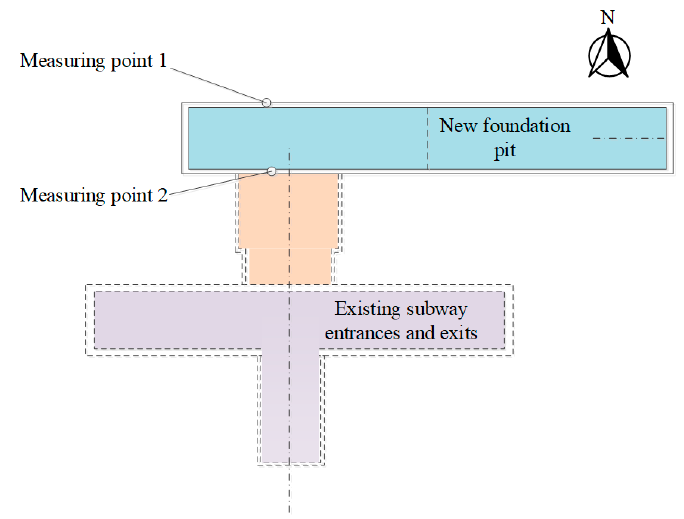
Figure 1. Plane position of new foundation pit and existing entrance and exits.